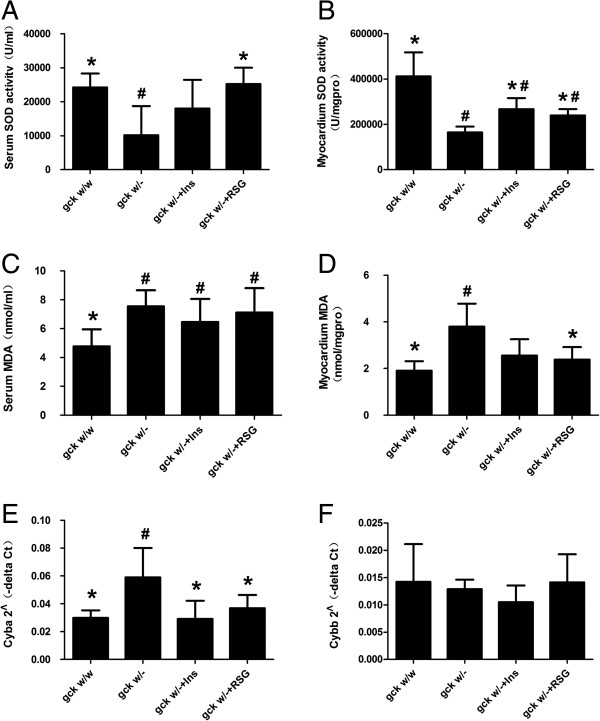
Oxidative stress in 60-week old liver-specific gck knockout mice. Serum and myocardium SOD activity (A and B), MDA levels (C and D), and relative levels of mRNA for Cyba (E) and Cybb (F) in the myocardial are shown for wild-type (gckw/w) and gck knockout (gckw/–) mice as well as knockout mice treated with insulin or rosiglitazone for 4 weeks. mRNA levels were determined by real-time PCR and corrected with beta actin as an internal standard. n = 6 for all samples. Asterisk (*) refers to statistical significance (P < 0.05) in comparisons with gckw/– mice, while # refers to comparisons with gckw/w mice.